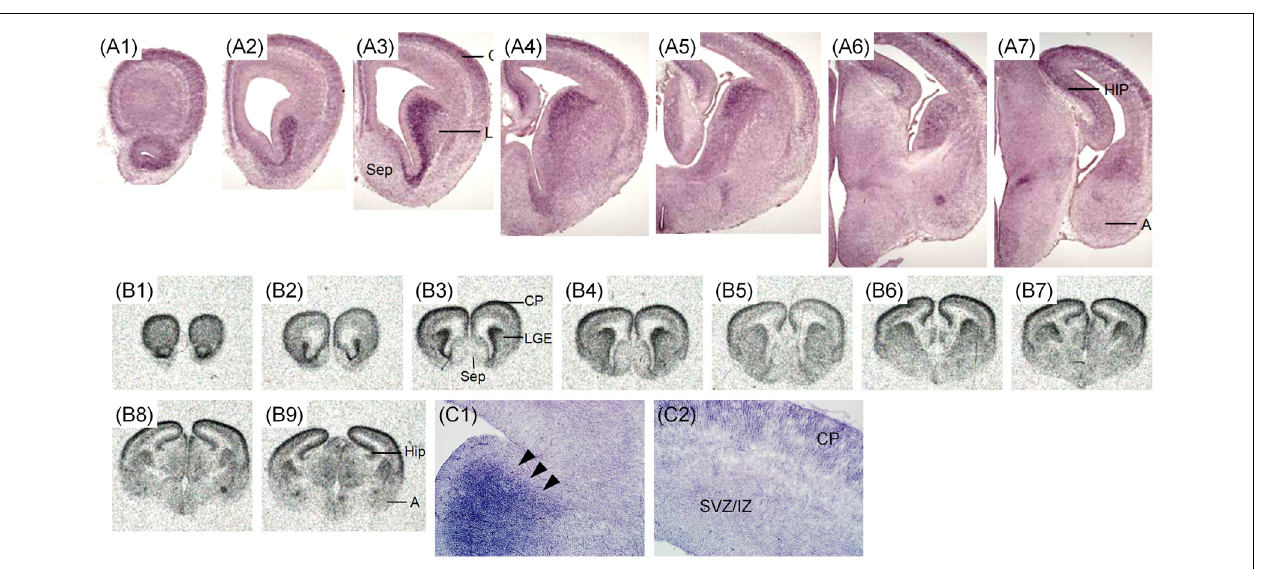
FIGURE 4 | Zswim6 mRNA expression pattern in E15.5 mouse forebrain. Expression pattern of Zswim6 mRNA detected by in situ hybridization with digoxigenin-labeled probes (A1–A7) and 35 S-labeled probes (B1–B9) from rostral to caudal levels. Zswim6 is mainly expressed in the SVZ of developing striatum with a border at the dorsal-most part (arrowheads in C1 ). Zswim6 is expressed in the developing cortex (C2) . A, amygdala; CGE, caudal ganglionic eminence; CP, cortical plate; Hip, hippocampus; IZ, intermediate zone; LGE, lateral ganglionic eminence; MGE, medial ganglionic eminence; Sep, septum; SVZ, subventricular zone; VZ, ventricular